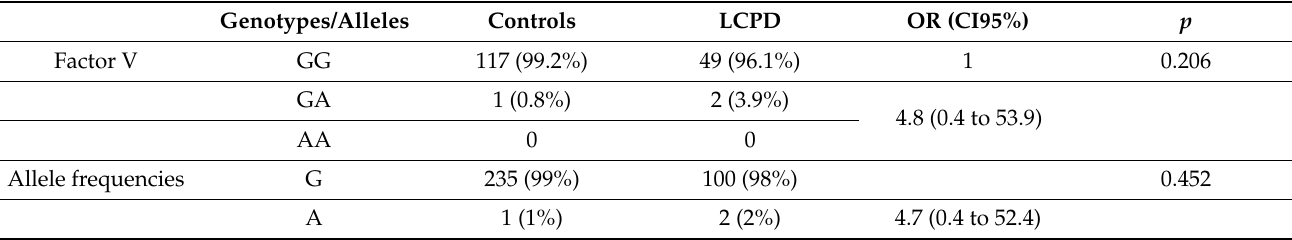
Table 1. Genotype and allele distribution among LCPD hips and